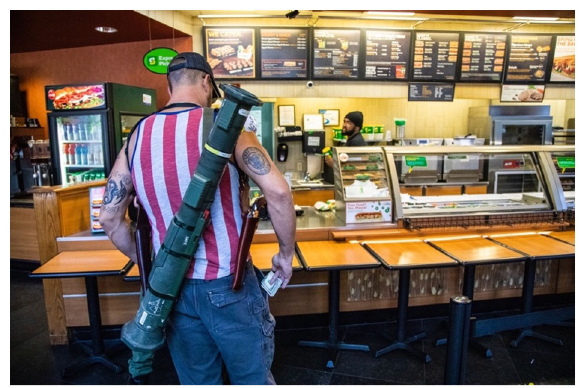
Fig. 1 Armed protester in a restaurant. Boogaloo Boys protester wearing a rocket launcher and two pistols. Photo by Travis Long. This fi gure is not covered by the Creative Commons Attribution 4.0 International